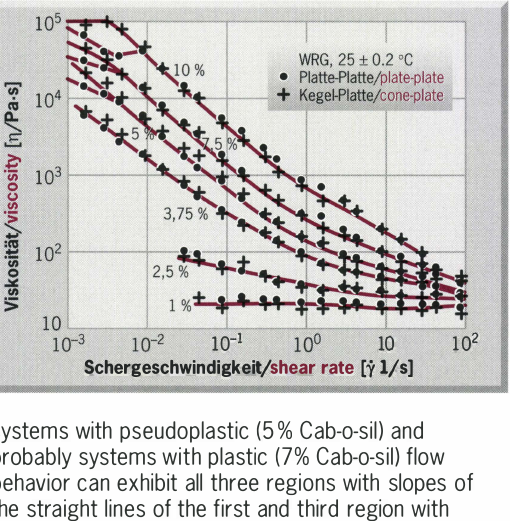
Fig. 3: The normal stress difference of the silicon oil with different Cab-o-sil concentrations as a function of the shear stress